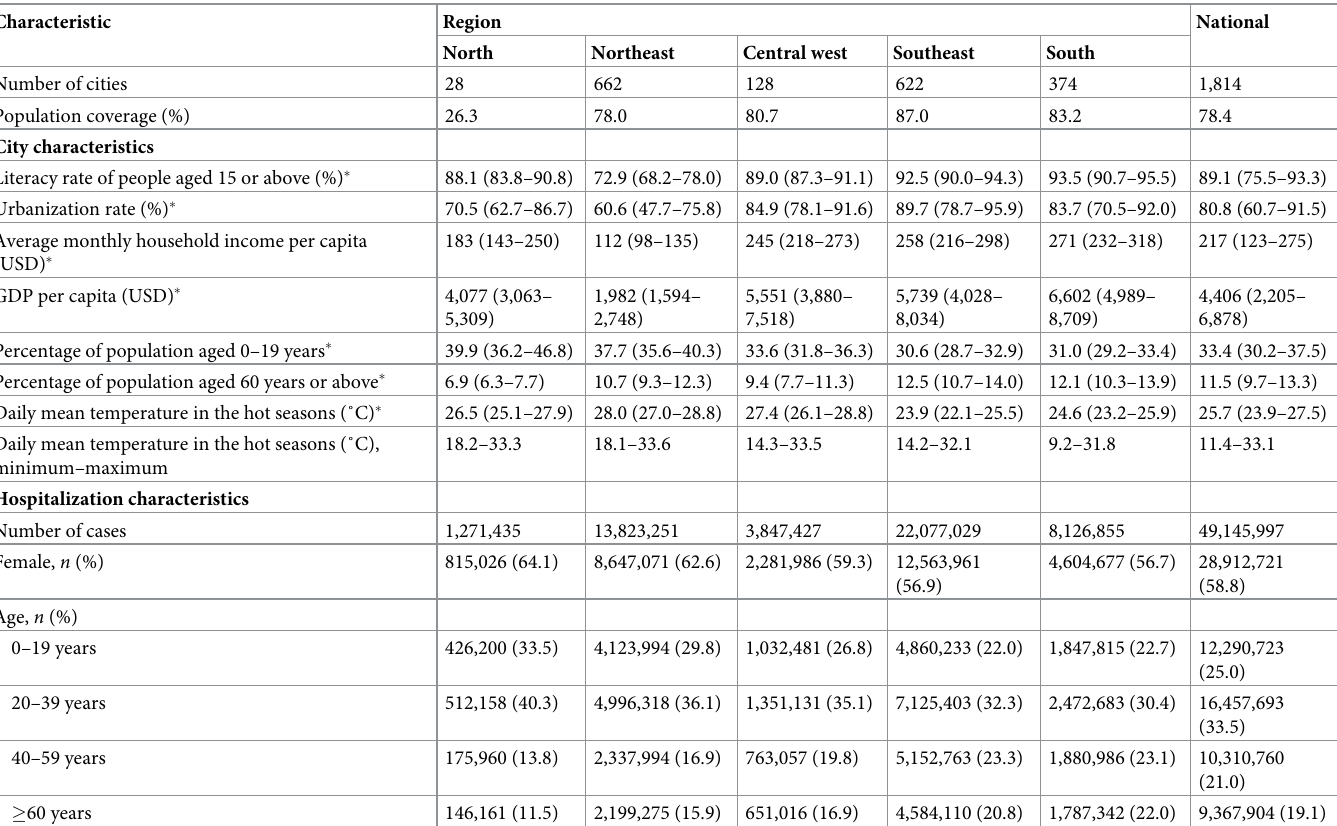
Table 1. Socioeconomic, demographic, and climatic characteristics of 1,814 included cities in Brazil and the hospitalization cases during the hot season, 2000–2015.